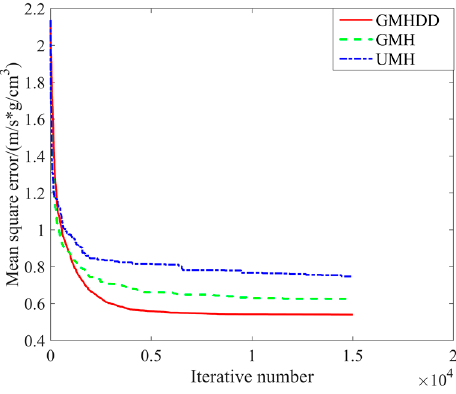
Figure 9. The relationship between the mean square error and iteration number from the three methods.